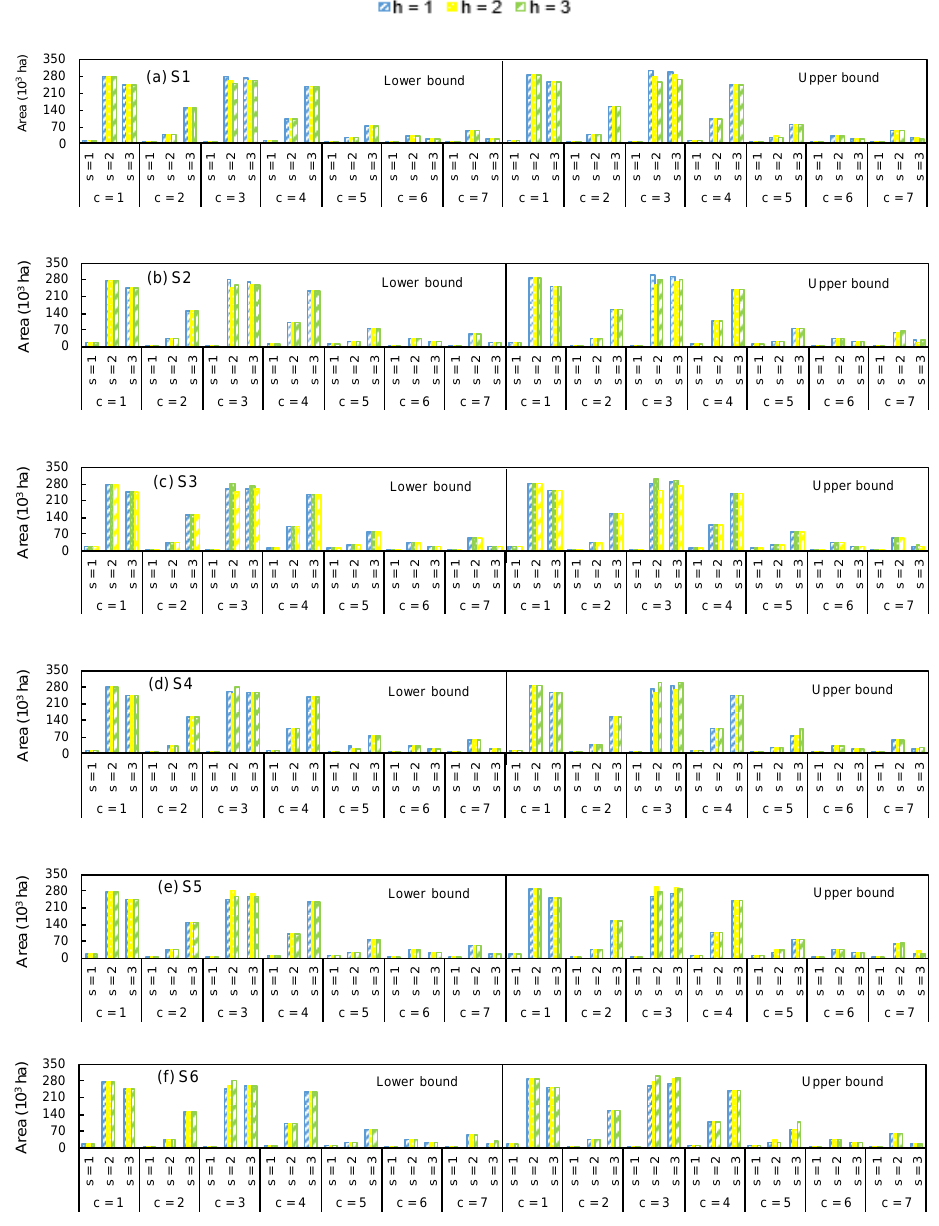
Figure 5. Cropland irrigated by surface water: ( a ) S1, ( b ) S2, ( c ) S3, ( d ) S4, ( e ) S5, ( f ) S6.